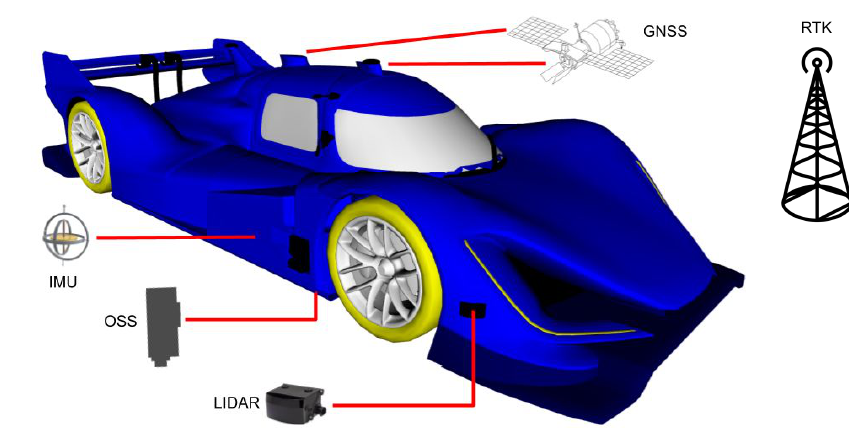
Figure 2. Overview of the DevBot sensors. Light Detection and Ranging (LiDARs) are mounted in the front, side and back of the car. Global Navigation Satellite Systems (GNSS) and Inertial Measurement Unit (IMU) sensors come from the OxTS system and the Optical Speed Sensor (OSS) measures longitudinal and lateral car velocities. The Real-Time Kinematic (RTK) base station is an optional system that allows extremely high positioning precision to the OxTS